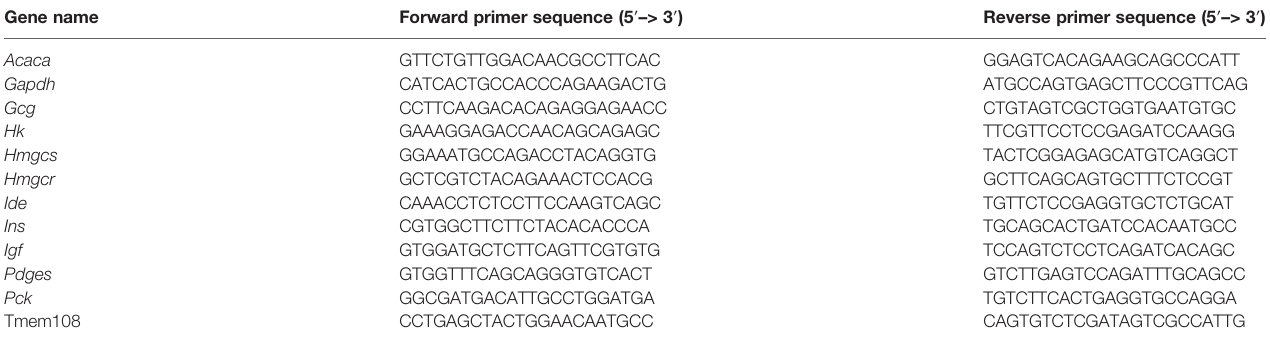
TABLE 1 | Primers sequences used in the real-time PCR